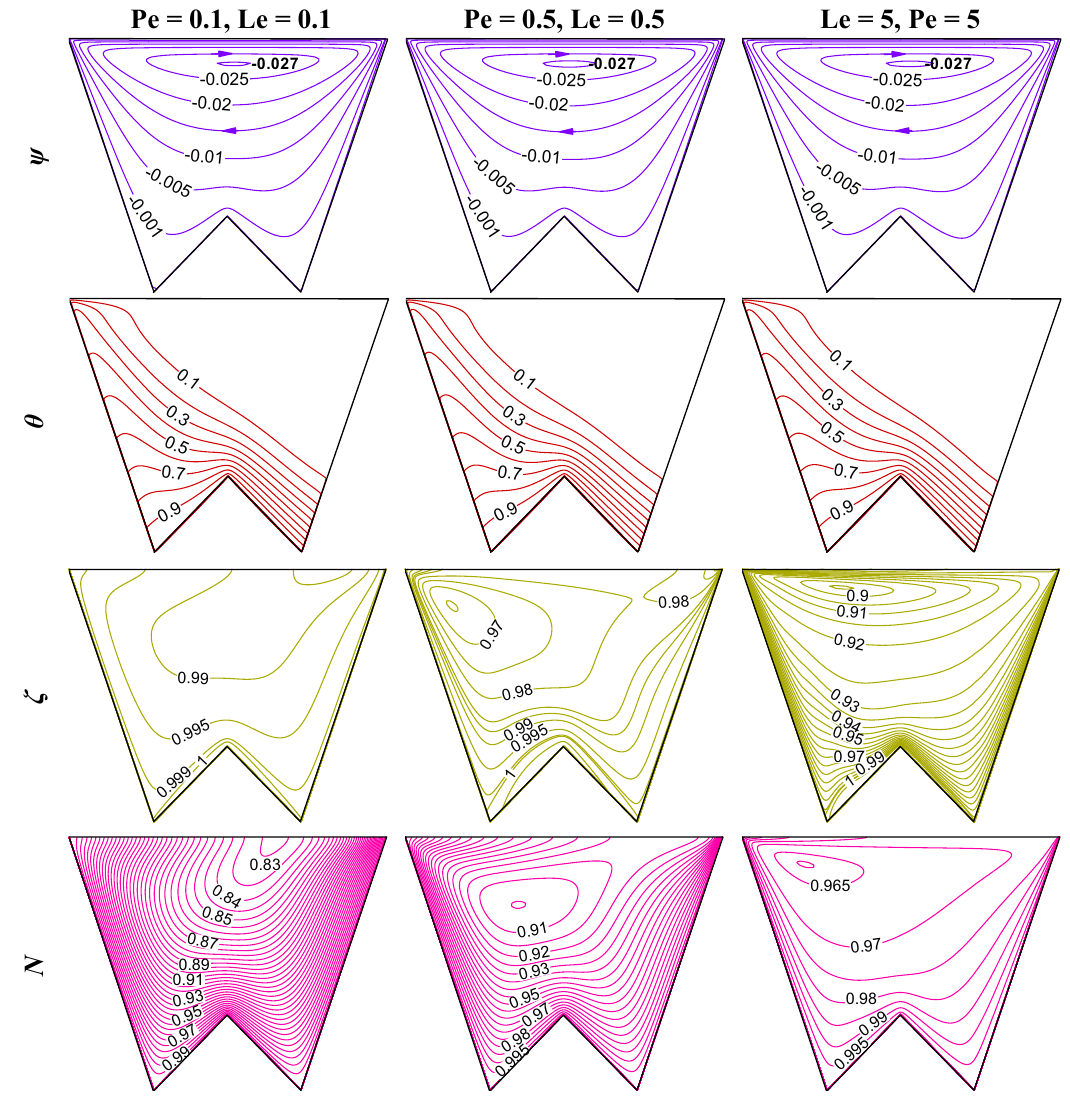
Figure 20. Contours of streamlines ( ψ ), isotherms ( θ ), isoconcentration of oxygen ( ζ ), and microorganisms ( N ) at R b = 50, Gr = 10 4 , Da = 10 –3 , Ha = 30, m = 1, δ = 0.3, γ =